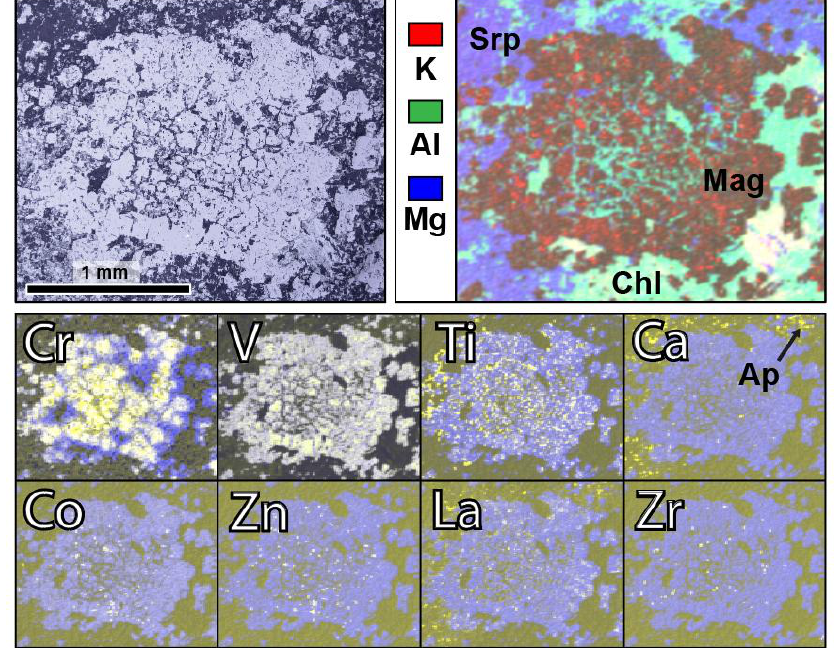
Figure 11. Reflected light image and chemical maps (LA-ICP-MS) of sample MS17-37. The 39 K (red) + 27 Al (green) + 24 Mg (blue) map displays three elements. The other chemical maps display the relative abundance of an element of interest ( 44 Ca, 59 Co, 52 Cr, 139 La, 47 Ti, 51 V, 66 Zn, and 90 Zr), represented by the colors red and green, against the internal standard for magnetite ( 57 Fe), represented in blue (for additional maps, see Supplemental Material S10). Mineral abbreviations are as reported in the literature [34].